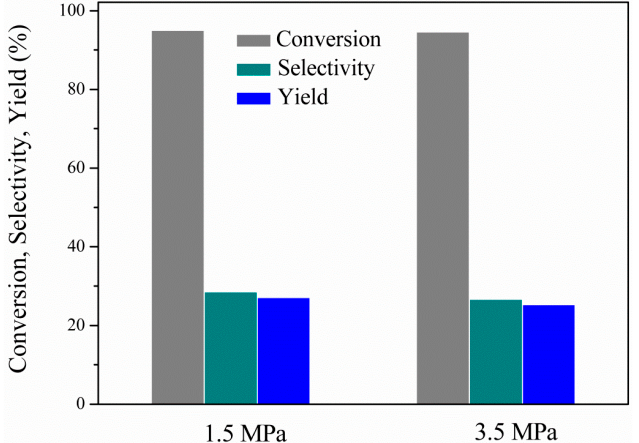
Figure 7. Effect of system pressure on glycerol conversion, 1,2-PDO selectivity and yield: 250 °C, 4 h, 7.1 wt% EtOH, 11.3 wt% glycerol (ethanol/glycerol molar ratio = 1.25) and water, catalyst/glycerol + ethanol weight ratio =